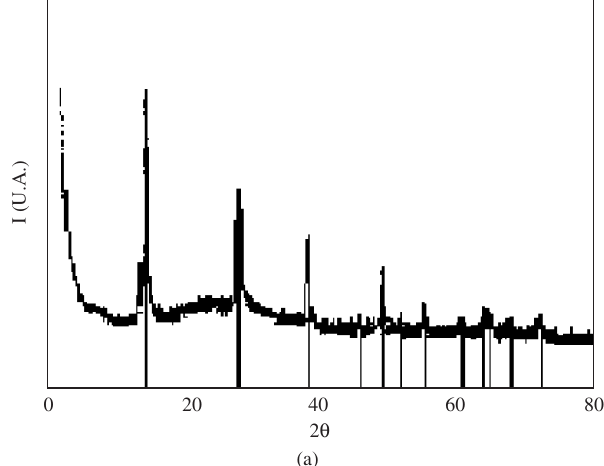
Table 1. Textural properties of the samples. Sample